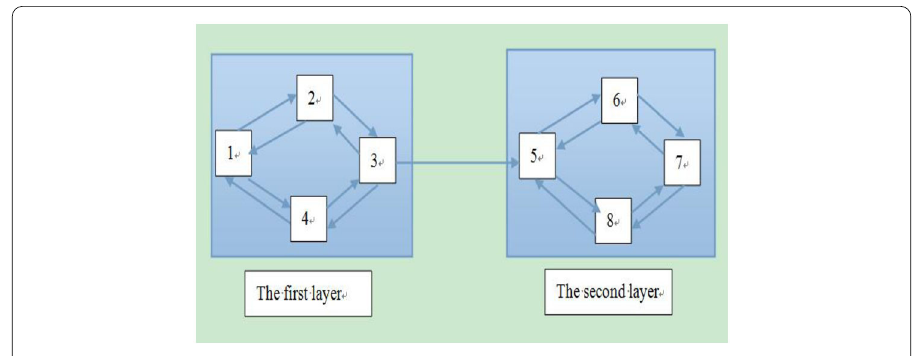
Figure 2 Strongly connected